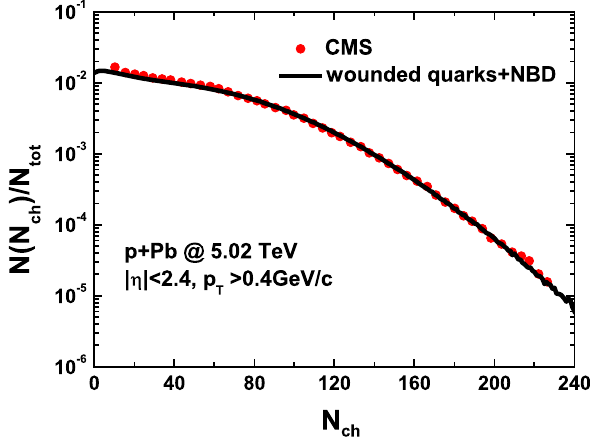
Fig. 2 The multiplicity distribution of charged hadrons at | η | < 2 . 4 and p T > 0 . 4GeV / c in5.02TeVp+PbcollisionsfromtheMCGlauber model of wounded quarks supplemented with negative binomial distri- butiononeachparticipant(woundedquarks+NBD),comparedtoCMS data